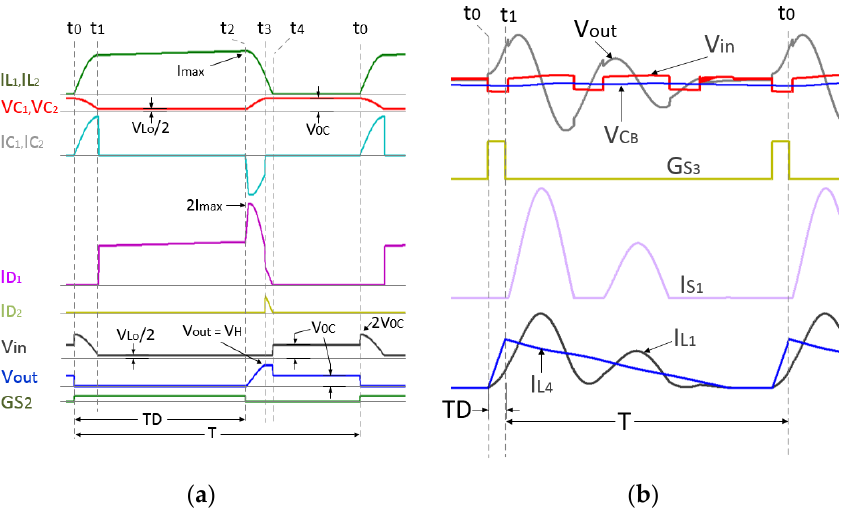
Figure 2. Waveforms: ( a ) step-up mode, ( b ) step-down mode.